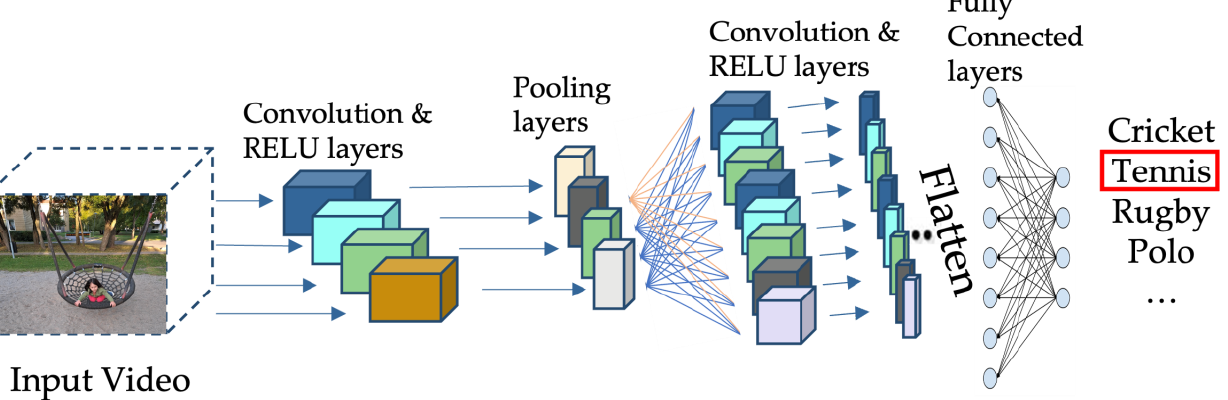
Figure 3. An example of 3D-CNN architecture to classify videos.